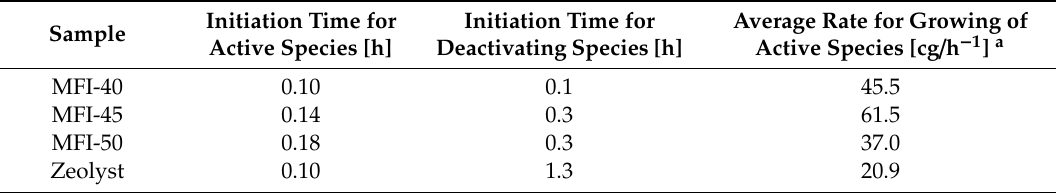
Figure 9. The evolution of intermediate species as a function of time; red represents the behavior of active species, while black represents the behavior of deactivated species.